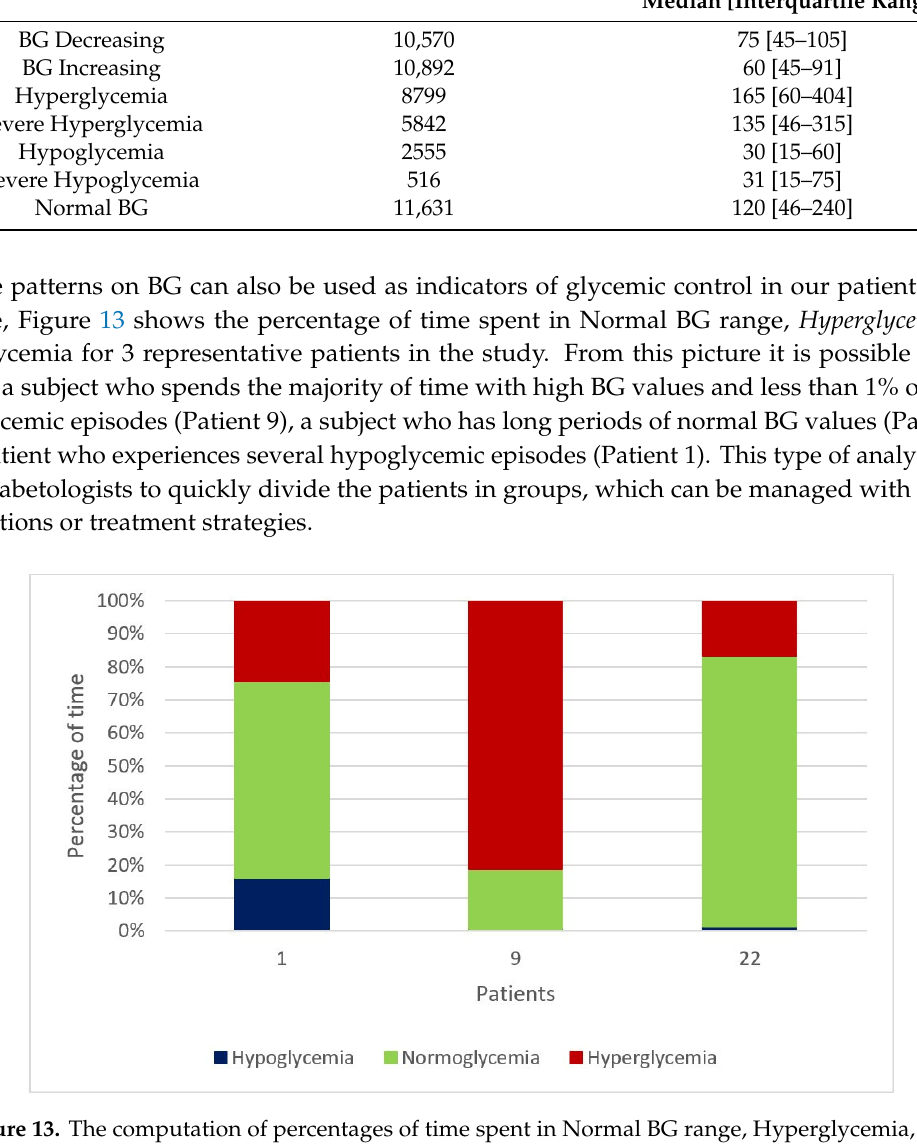
Figure 13. The computation of percentages of time spent in Normal BG range, Hyperglycemia, and Hypoglycemia can easily identify different types of patients.